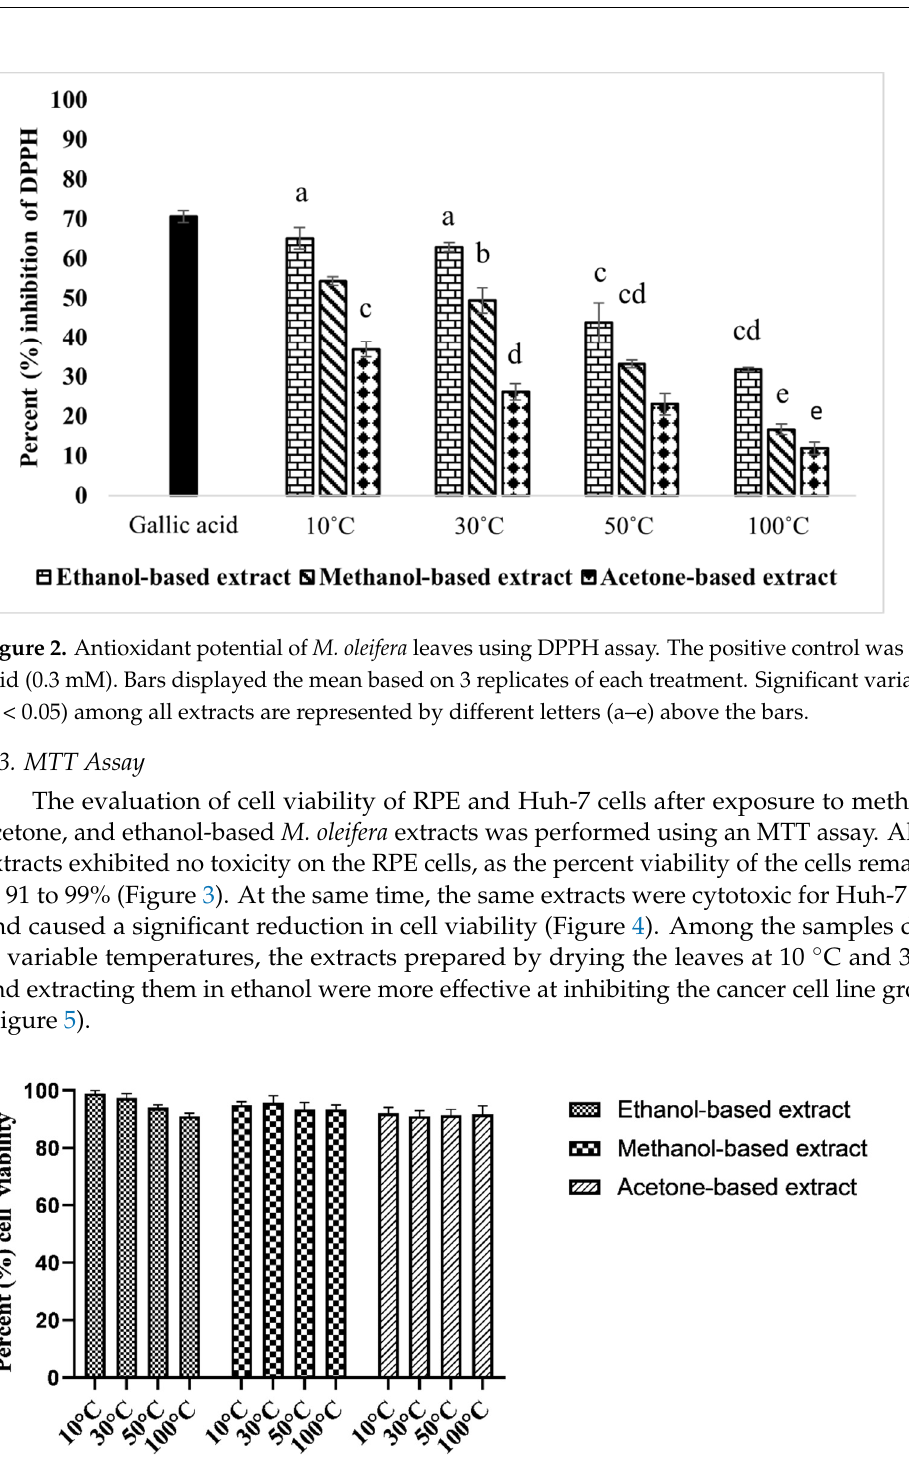
Figure 3. Retinal pigment epithelial cell viability after exposure to twelve different M. oleifera extracts prepared by drying the leaves at variable temperatures and extracting them in three different solvents. Extracts were tested at 0.1 mg/mL. Data are expressed as percent cell viability after treatment with plant extract. Bars displayed the mean ± standard